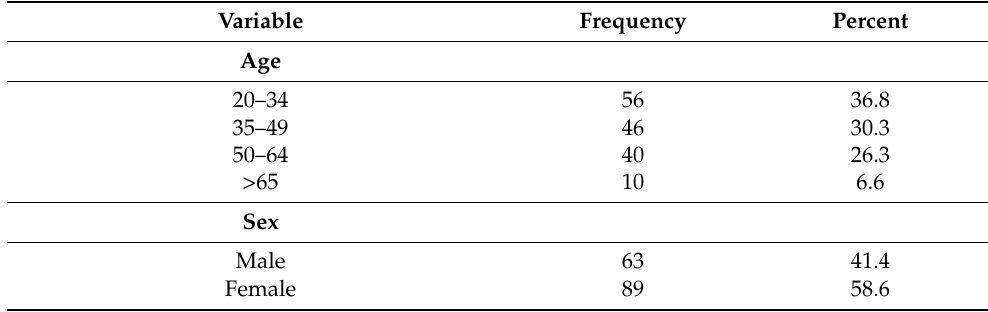
Table 1. Demographic characteristics and participants’ level of awareness and knowledge of